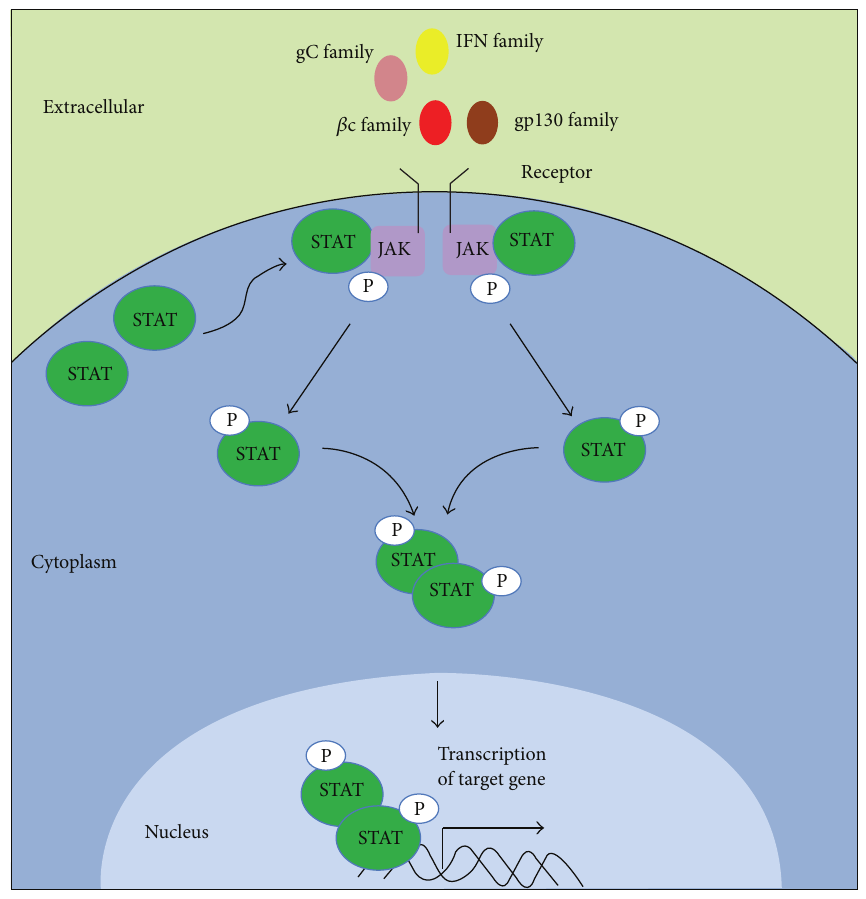
Figure 1: The canonical JAK-STAT signaling pathway. Ligands bind to corresponding receptors and allow the appropriate JAKs to phosphorylate each other, leading to their activation. Activated JAKs phosphorylate STATs, followed by subsequent dimerization of the STATs. STAT dimers are transported into the nucleus and bind the promoters of target genes to initiate transcription. The ligands include interleukins (IL-10, IL-19, IL-20, and IL-22), IFNs (IFN 𝛼 , IFN 𝛽 , and IFN 𝛾 ), gp130 family (IL-6, IL-11, oncostatin M, leukemia inhibitory factor, cardiotrophin-1, granulocyte colony-stimulating factor, IL-12, Leptin, and ciliary neurotrophic factor), and 𝛾 -chain (gC) family (IL-2, IL-4, IL-7, IL-9, IL-15, and